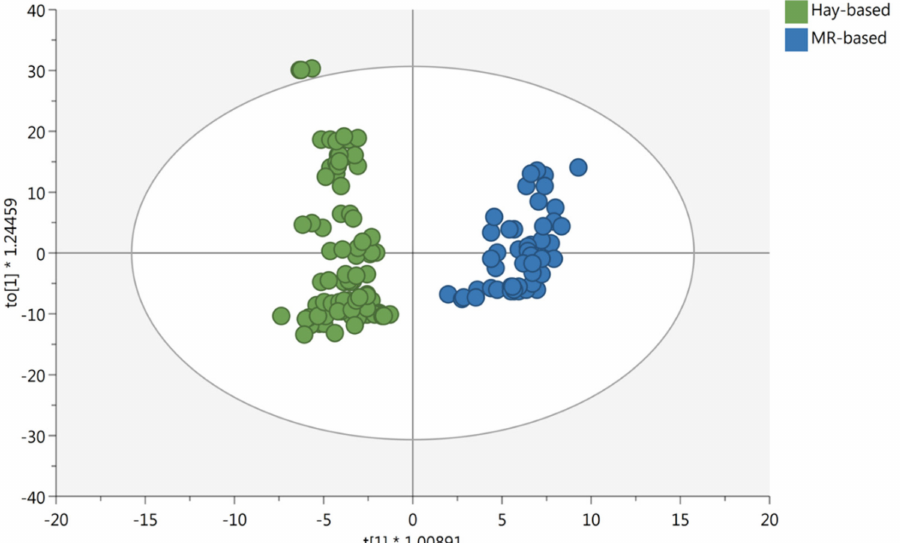
Figure 2. Orthogonal projection to latent structures discriminant analysis (OPLS-DA) considering the milk samples from different feeding regimens (i.e., H-FS: hay-based feeding system; MR-FS: fresh forage/hay-based feeding